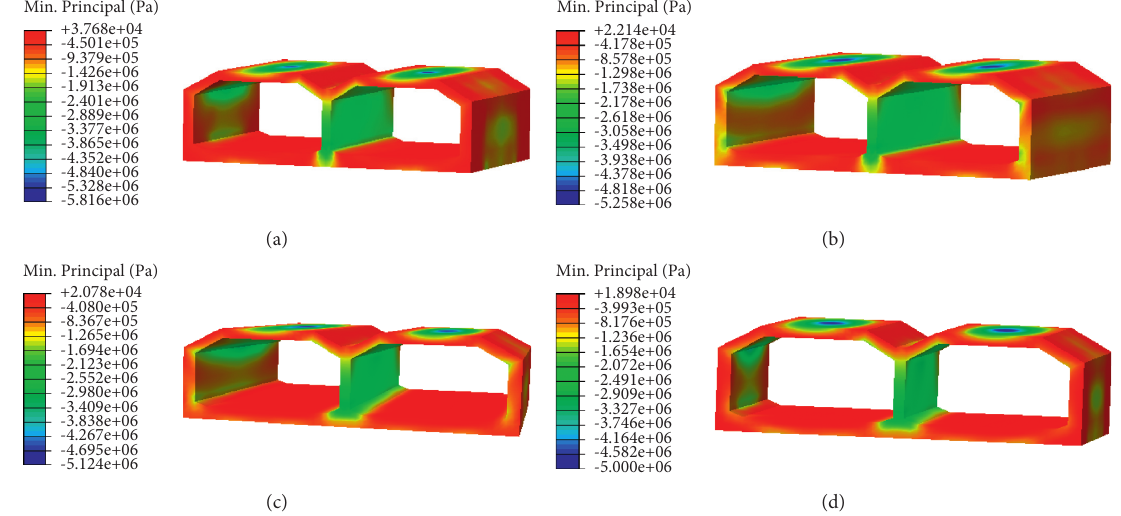
Figure 7: Cloud chart of minimum principal stress of tunnel lining. (a) Condition 1; (b) Condition 2; (c) Condition 3; (d) Condition